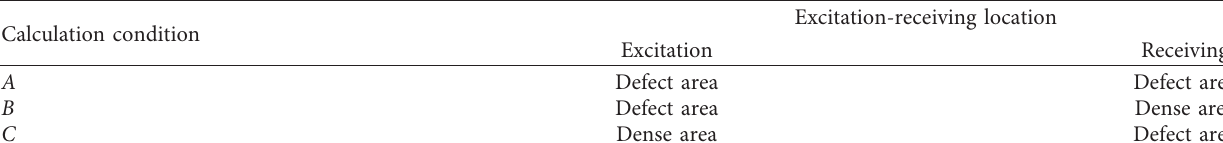
Table 3: Sensitivity analysis of different excitation–receiving locations.